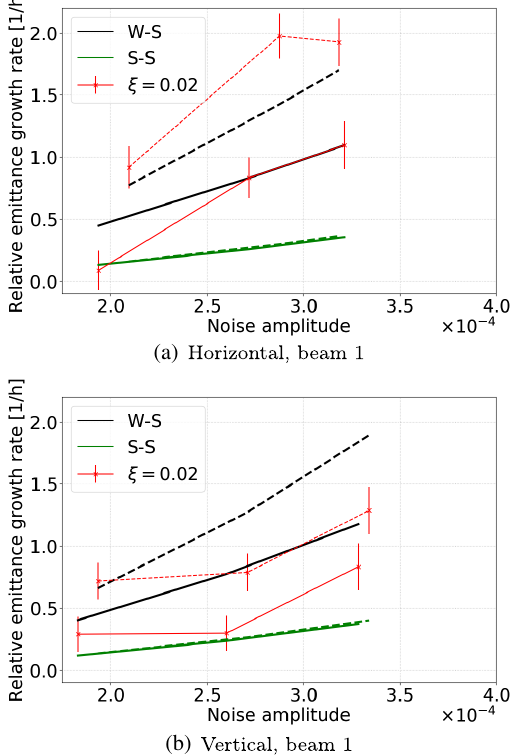
FIG. 7. Relative emittance growth rate measured in an experi- ment at the LHC in 2016, during which single bunches were brought into collision at 6.5 TeV in IPs 1 and 5 reaching a total beam-beam tune shift of ξ ¼ 0 . 01 . The controlled source of noise with a fixed amplitude was activated for 10 minutes. The emittance quoted here results from the comparison of the fit over these 10 minutes with respect to 10 minutes in absence of noise, such that it corresponds to the sole contribution of the artificial noise. The uncertainty on the measurement is dominated by the resolution of the emittance measurement, its impact on the fit values are shown with error bars. The experiment was repeated with feedback gains of 0.02 and 0.005 represented with solid and dashed blue lines. The black and green lines show the corre- sponding predictions using the weak-strong and strong-strong model respectively. The results are shown for the first beam, the other exhibited a similar behavior [25].